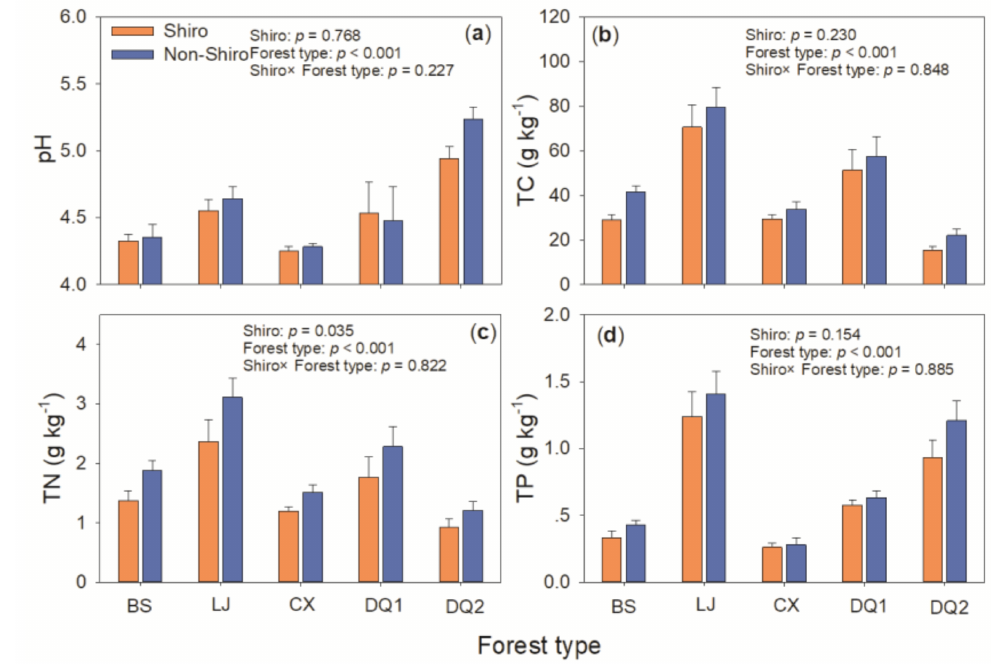
Figure 1. Soil pH ( a ), total carbon TC ( b ), total nitrogen TN ( c ), and total phosphorus TP ( d ) in the shiro and bulk soil from Deqing (DQ1, DQ2), Lijing (LJ), Baoshan (BS) and Chuxiong (CX) in Yunnan, South-western